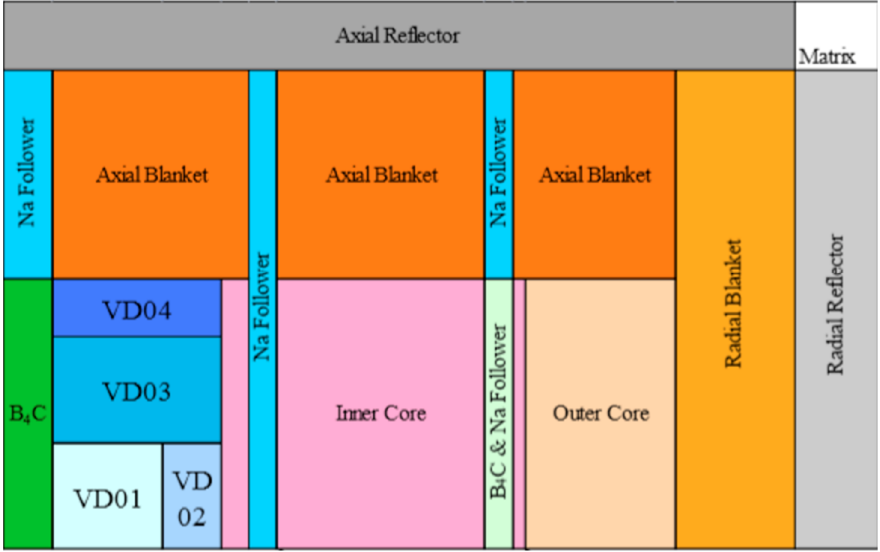
Figure 8. Arrangement of ZPPR-10B core fore sodium void reactivity evaluation. Table 6. Results and comparison of SVR value of ZPPR-9.